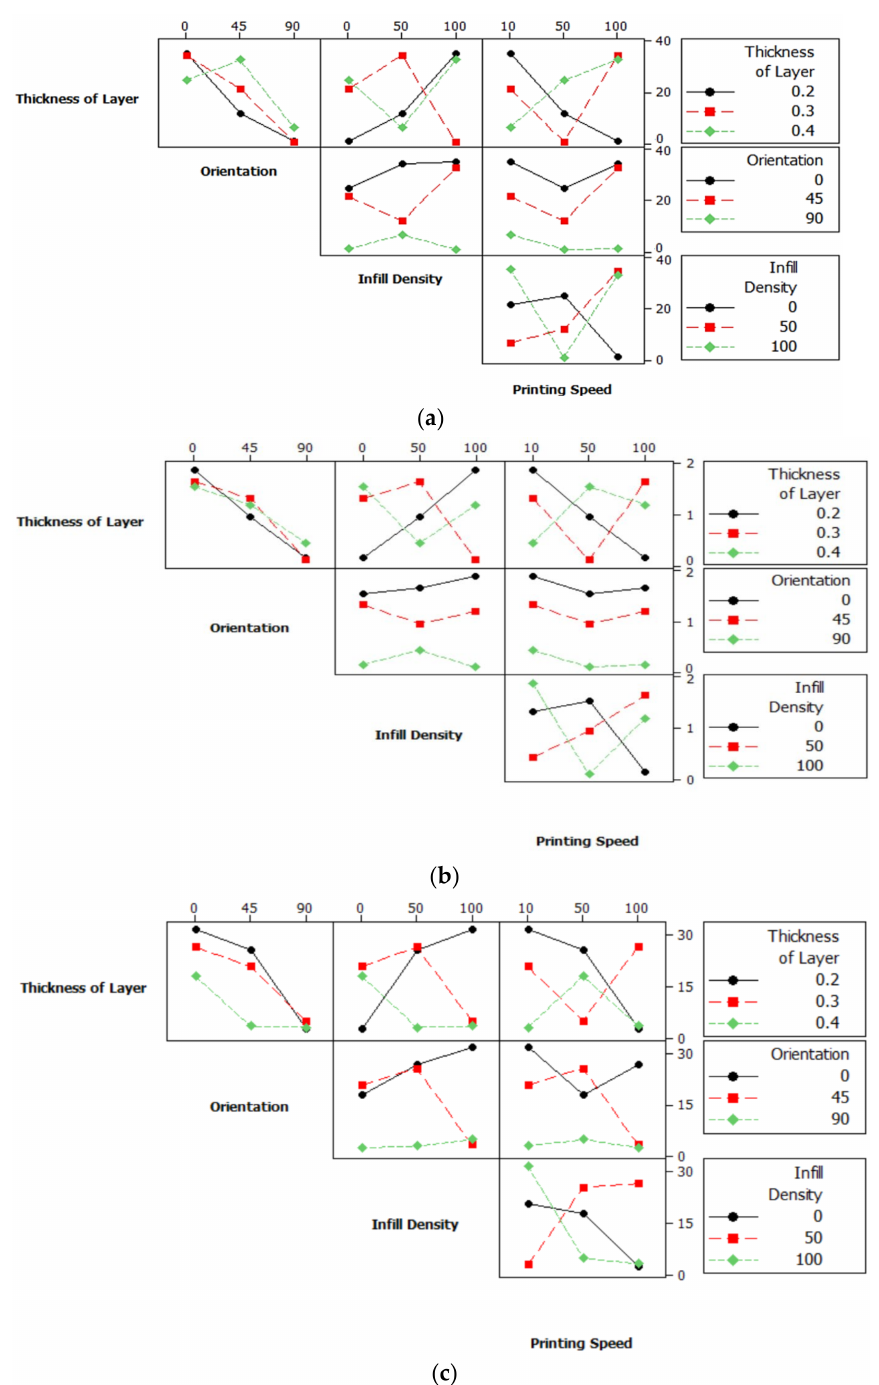
Figure 5. Interaction plots of ( a ) tensile strength ( b ) Young’s modulus and ( c ) flexural